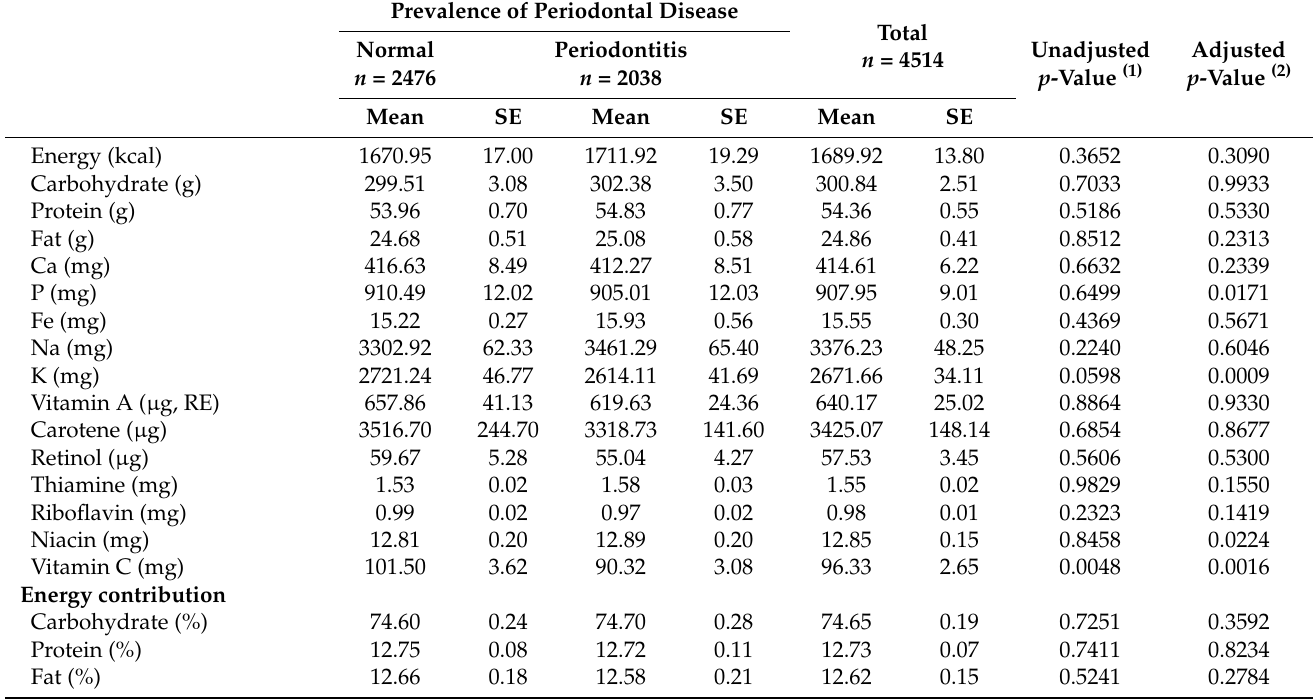
Table 4. Nutrient intake according to prevalence of periodontitis in survey